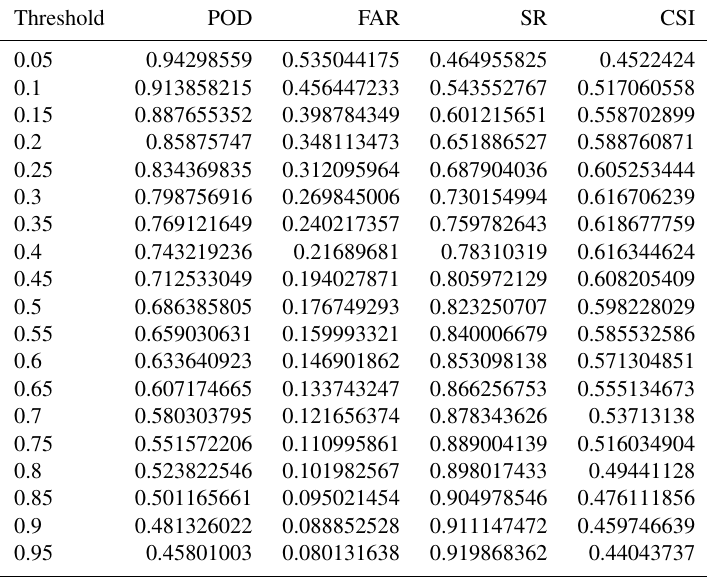
Table A2. POD, FAR, SR, and CSI values for using different thresholds in the two-step training model.